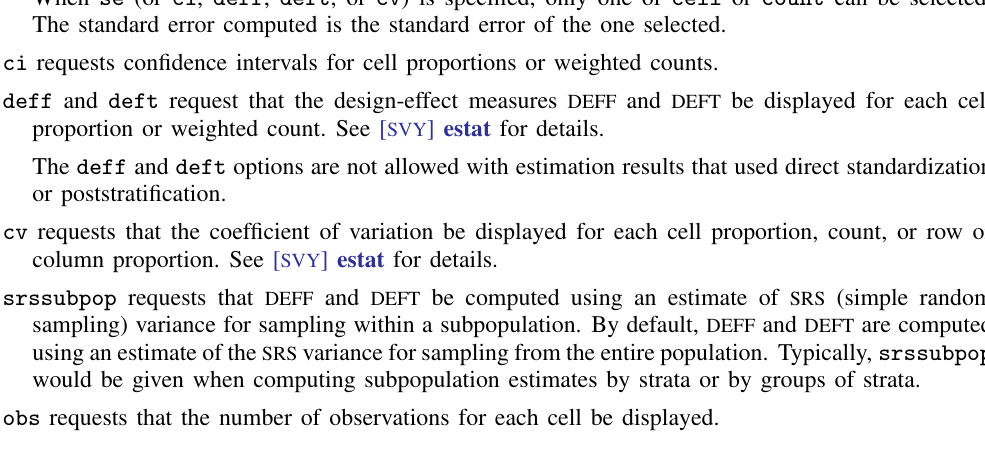
svy: tabulate oneway — One-way tables for survey data